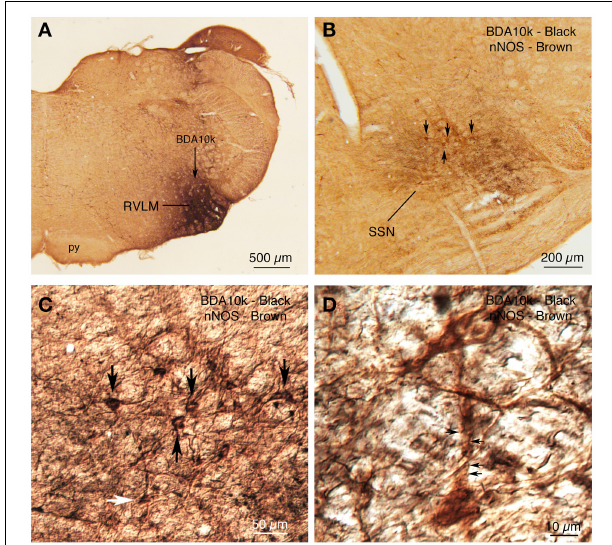
FIGURE 12 | (A) BDA10k injection in RVLM that yielded the anterograde labeling in choroidal SSN shown in (B) . (B) Two color DAB double labeling showing brown nNOS + prechoroidal neurons in SSN, overlapped by black BDA10k + fibers arising from RVLM. Some brown nNOS + neurons are indicated by arrows. (C) A differential contrast image (DIC) showing a higher power detail of the field shown in (B) . The same neurons indicated with arrows in (B) are indicated by arrows in (C) . One additional neuron is indicated by a white arrow and is shown at higher power in (D) . (D) The DIC image shows a brown nNOS neuron receiving contacts, some indicated by arrows, from black BDA10k + fibers and terminals labeled from